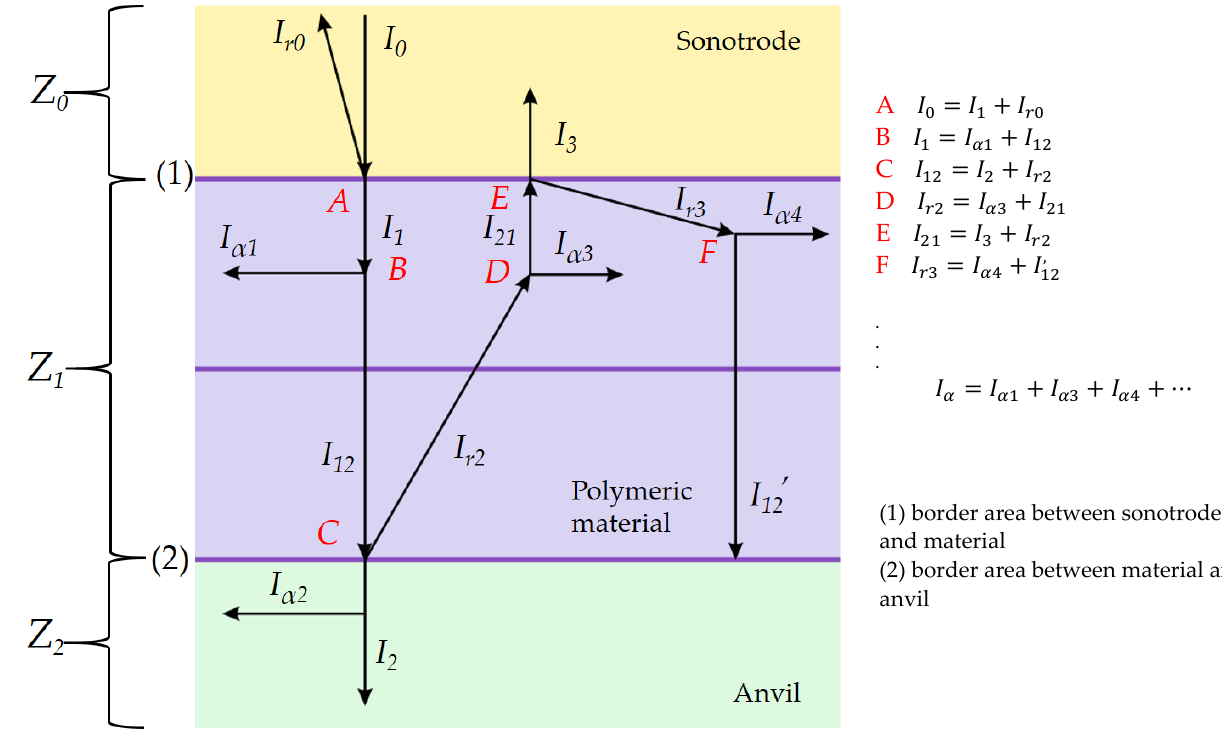
Figure 1. Machine components and acoustic parameters used in the ultrasonic welding process utilizing the rotary sonotrode ultrasonic welding machine.